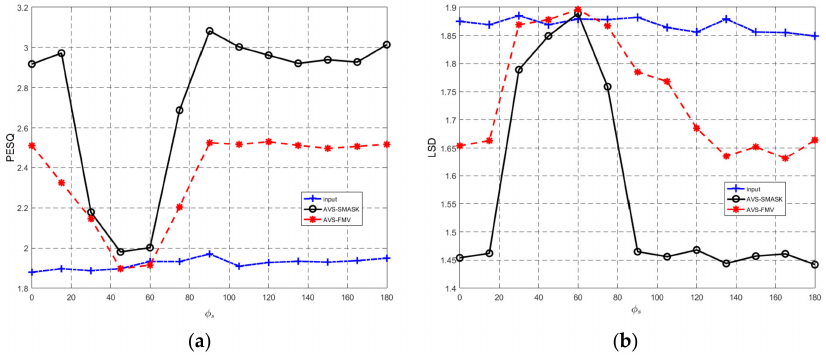
Figure 10. (Experiment 4) The performance versus φ s . ( a ) PESQ results and ( b ) LSD